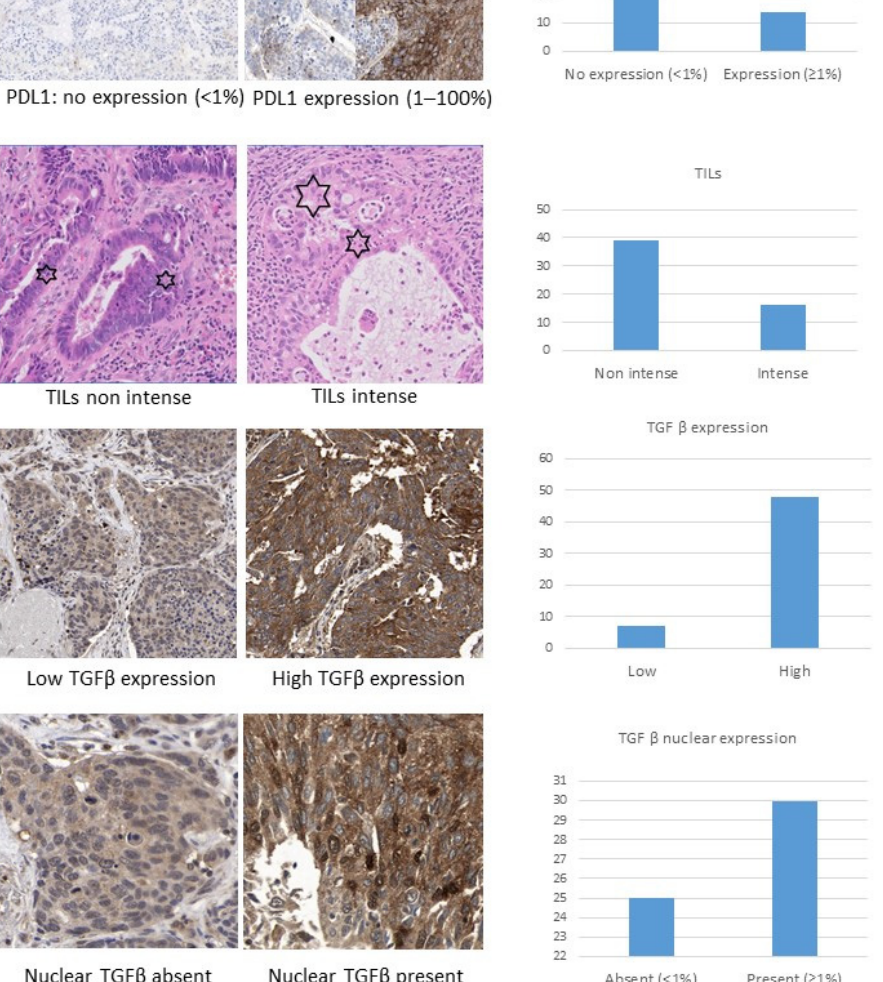
Figure 1. Histological algorithm of evaluation (as described in Sections 4.2–4.4 of Section 4) and frequency distribution for the biomarkers of interest. The six-pointed stars show intraepithelial lymphocytes. All images at 20 × magnification (digital zoom) except for TGF- β nuclear staining (40 ×